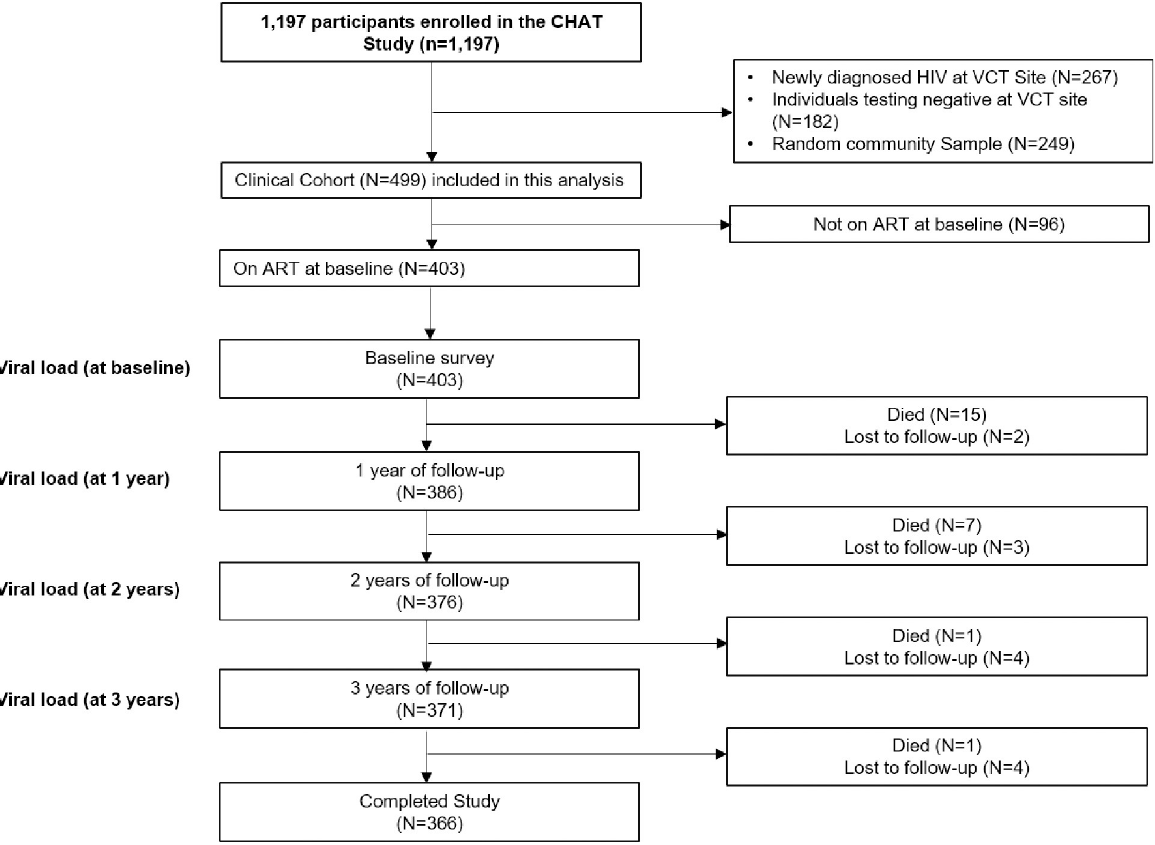
Fig 2. Flow diagram of study participants enrolled in the coping with HIV/AIDS in Tanzania (CHAT) study, northern Tanzania (2008– 2012).